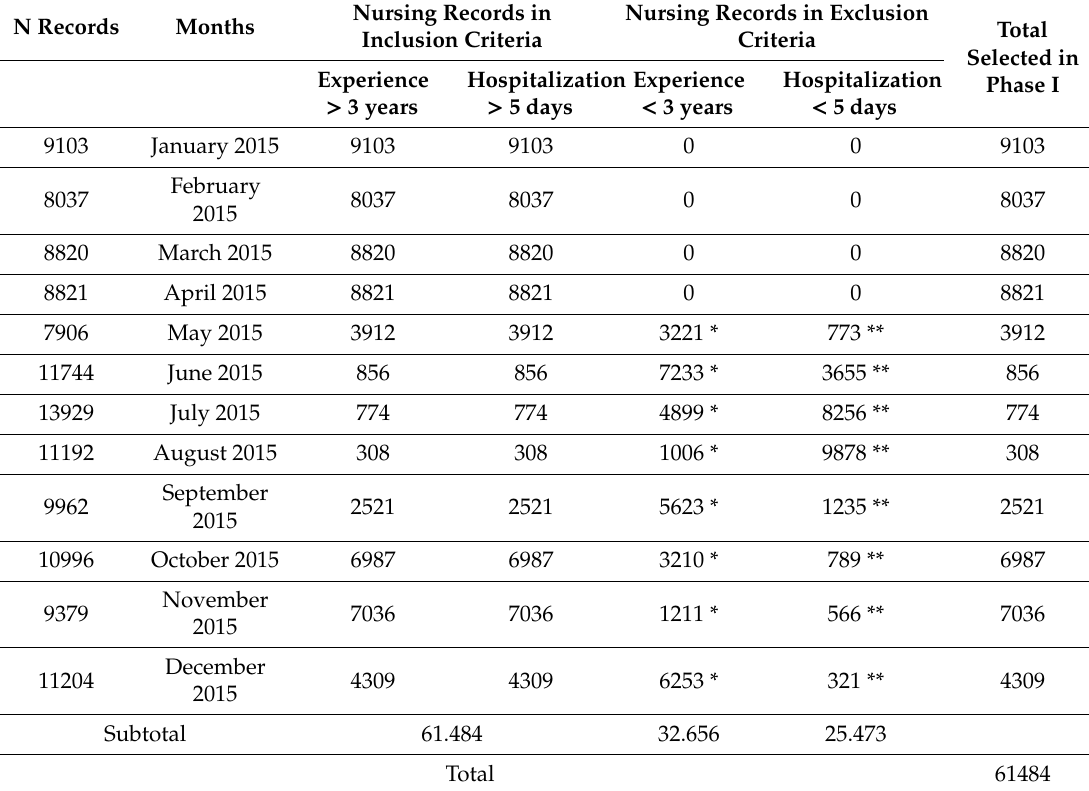
Table 1. Nursing record selection